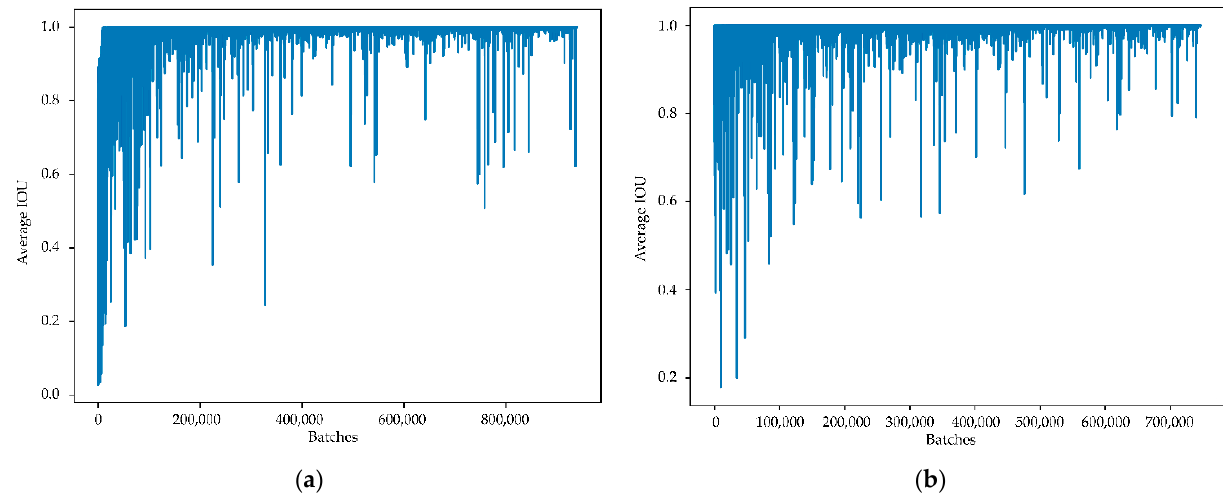
Figure 3. ( a ) The change in region average IOU of YOLOv3 to train real TC images; ( b ) the change in region average IOU of NDFTC to train real TC images.